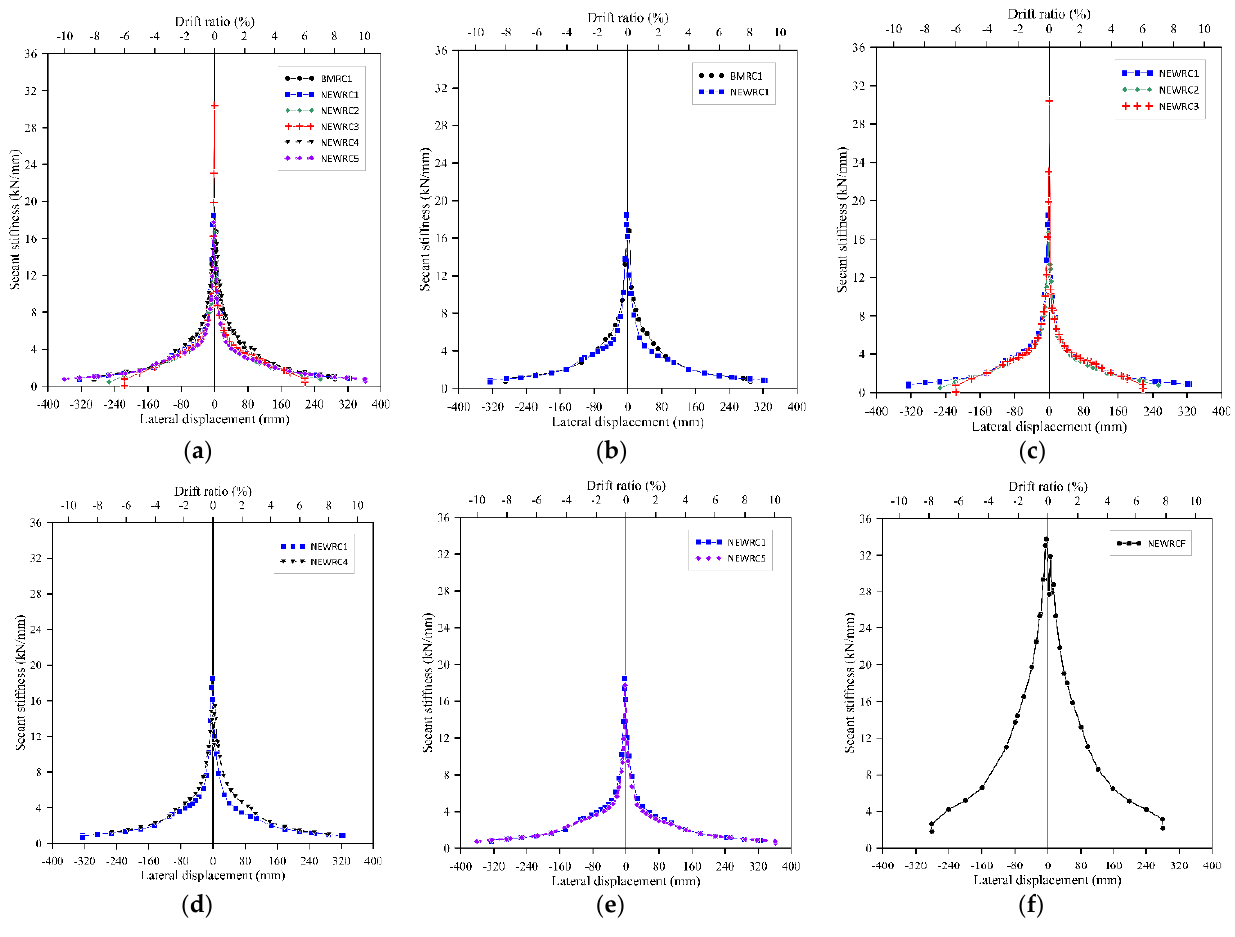
Figure 11. Stiffness degradation curves: ( a ) BMRC1 and NEWRC1 – 5; ( b ) BMRC1 and NEWRC1; ( c ) NEWRC1, 2, and 3; ( d ) NEWRC1 and 4; ( e ) NEWRC1 and 5; ( f ) NEWRCF.